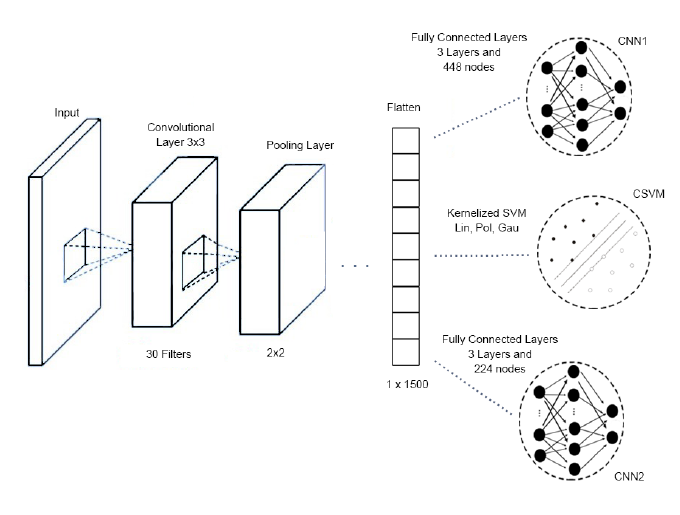
Figure 11. Representation of models. Source: adapted from [54] and prepared by the